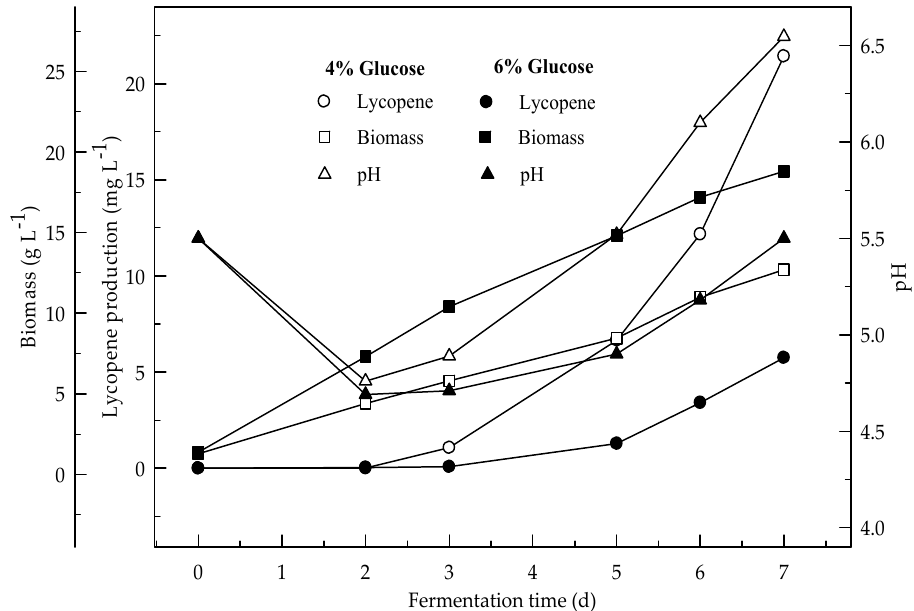
Figure 2. Changes in lycopene production, biomass formation and pH with initial pH 5.5 in a medium containing 4 and 6% glucose.